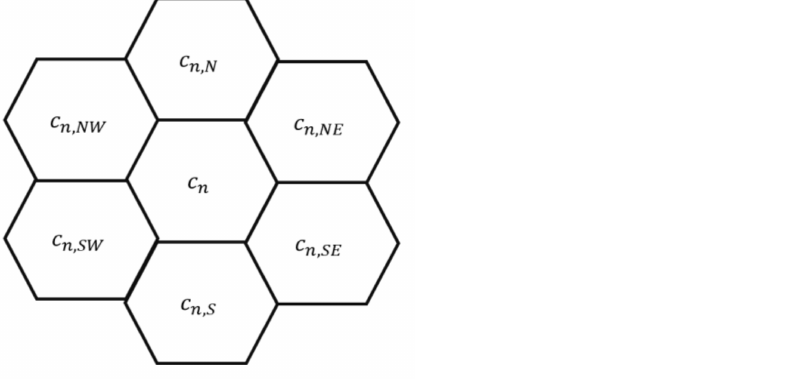
Figure 2. Fragment of a Goldberg polyhedron: a hexagon and its neighborhood.